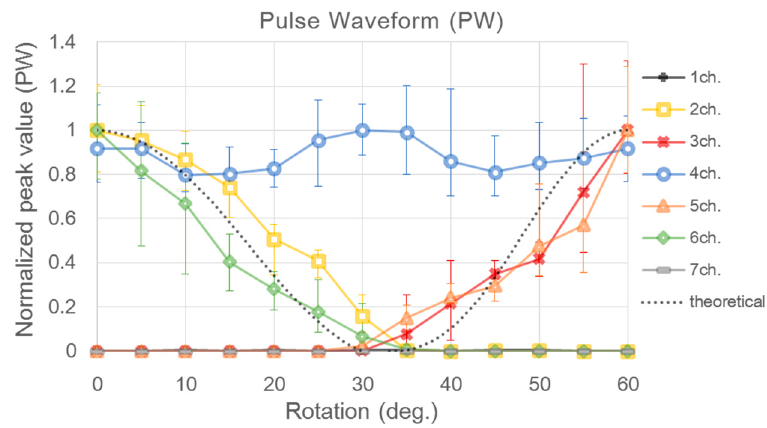
Figure 13. Normalized peak value of pulse wave signal for each sensor channel with respect to sensor rotation from 0° to 60°.